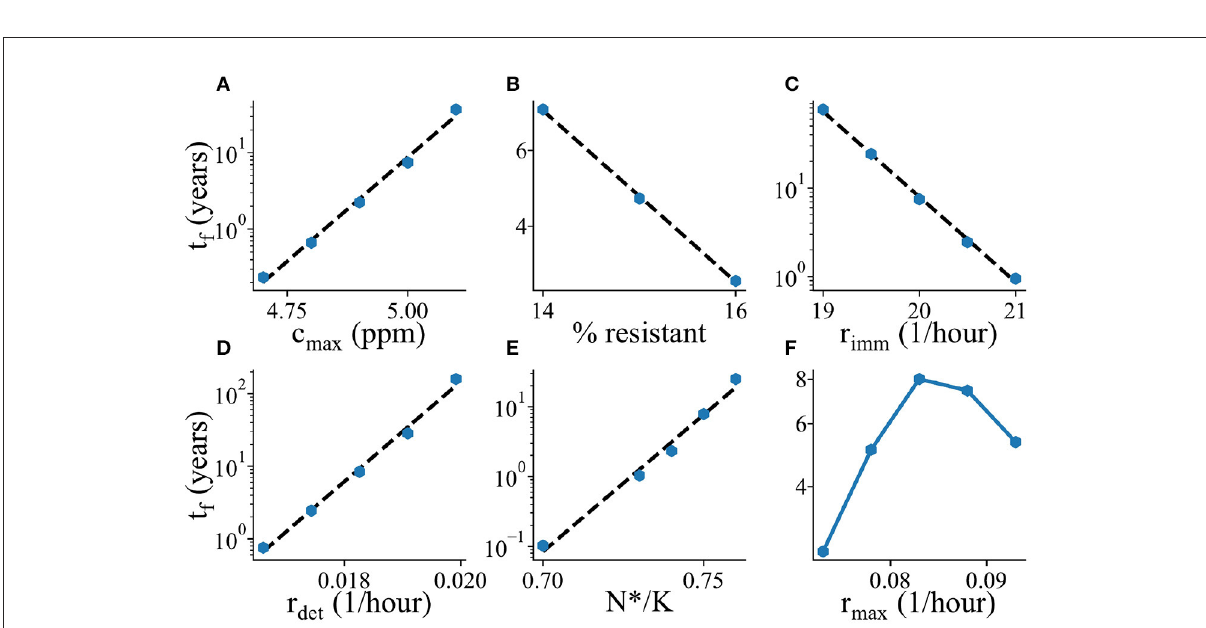
FIGURE6 Parameter dependence of mean biofilm establishment time. The mean biofilm establishment time t f is plotted as a function of various model parameters. (A) Maximal biocide concentration c max , (B) Percentage of biocide resistant microbes in the ocean, (C) Immigration rate r imm ,